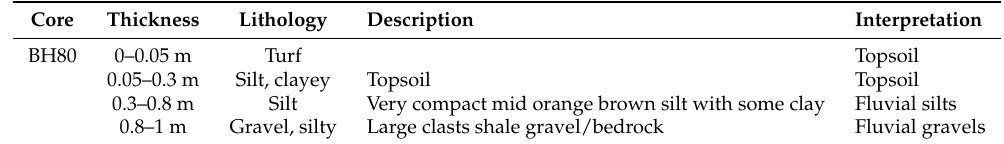
Figure 13. Detail of the geophysical anomaly parallel to the road in Otegi area (The area is highlighted in the general context of Figure 6). GPR results over magnetic response map ( − 5 nT black, 6 nT white). ( a )Time slice at 0.36–0.55 m bgl; ( b ) Time slice at 0.61–0.80 m bgl. ( c )Interpretation scheme of GPR results. Table 4. Description of core